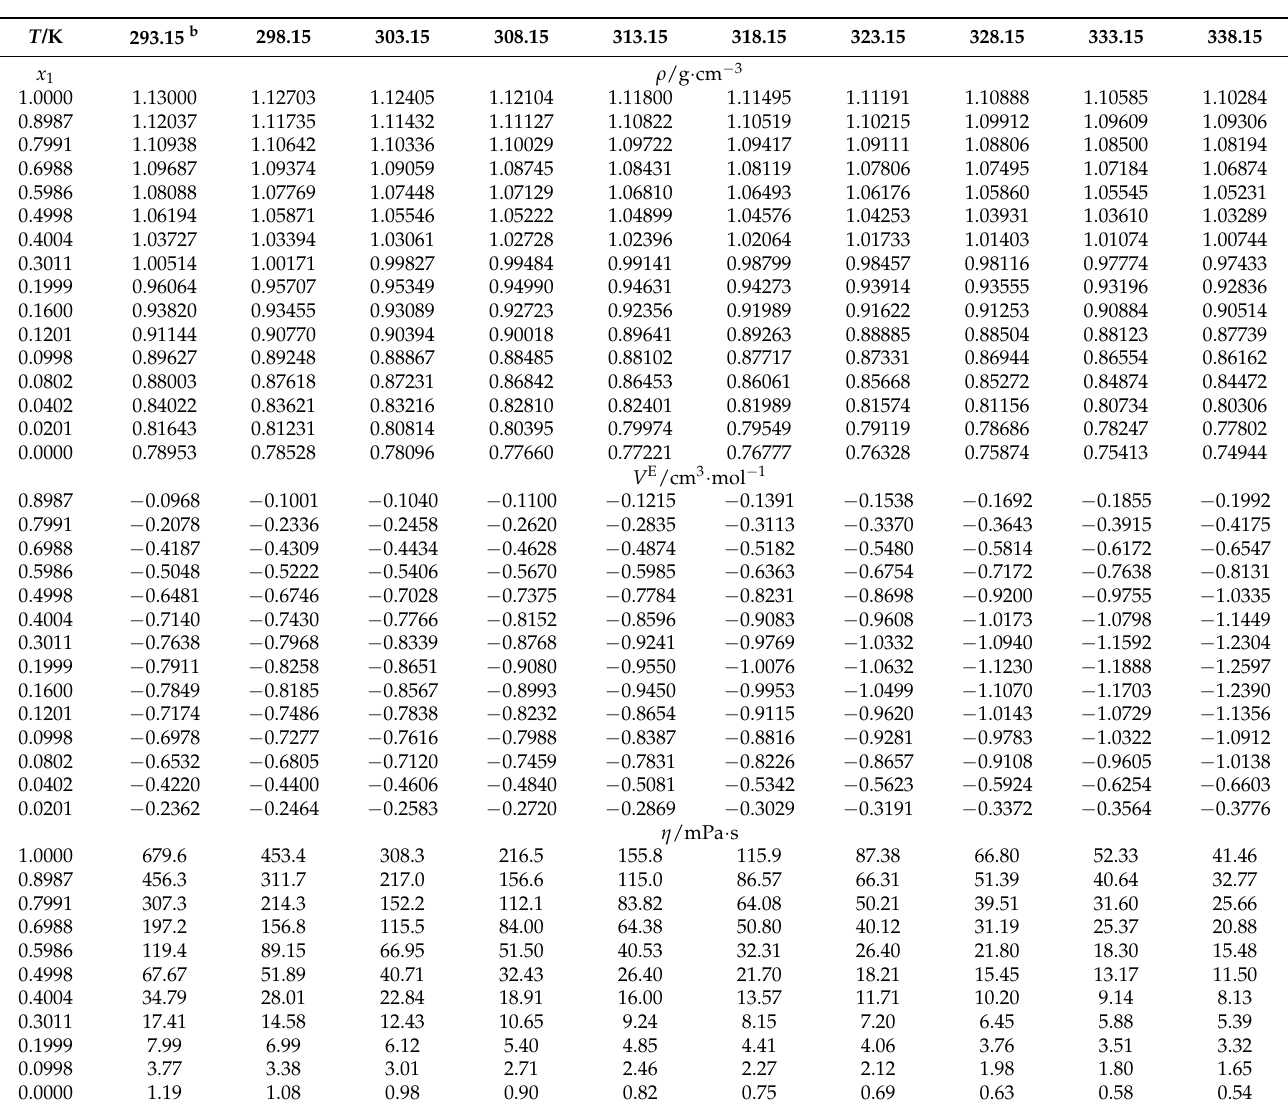
Table 8. Experimental values of density, ρ /g · cm − 3 , excess molar volume, V E /cm 3 · mol − 1 ,